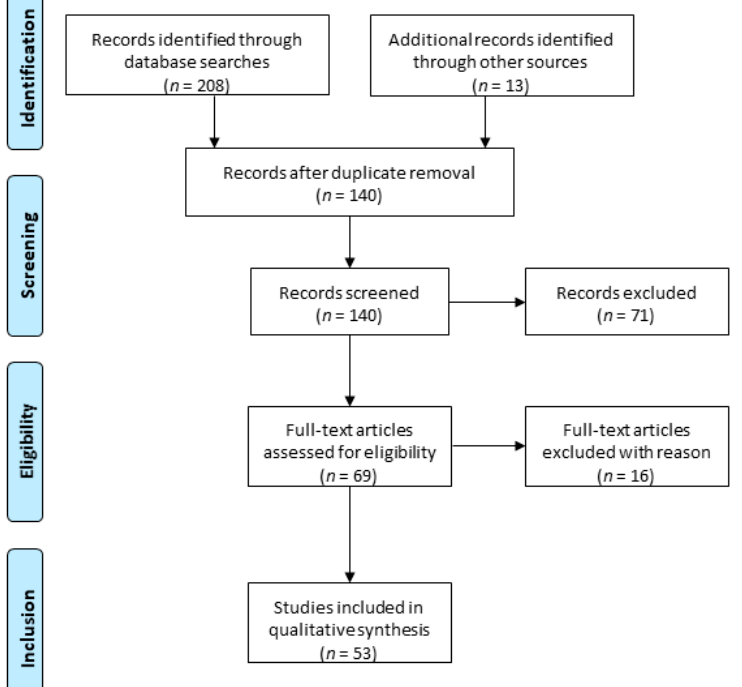
Figure 1. Preferred Reporting Items for Systematic Reviews and Meta-Analyses (PRISMA) flowchart.